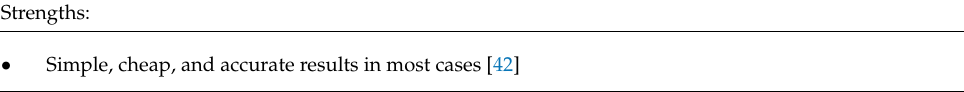
Strengths and Limitations